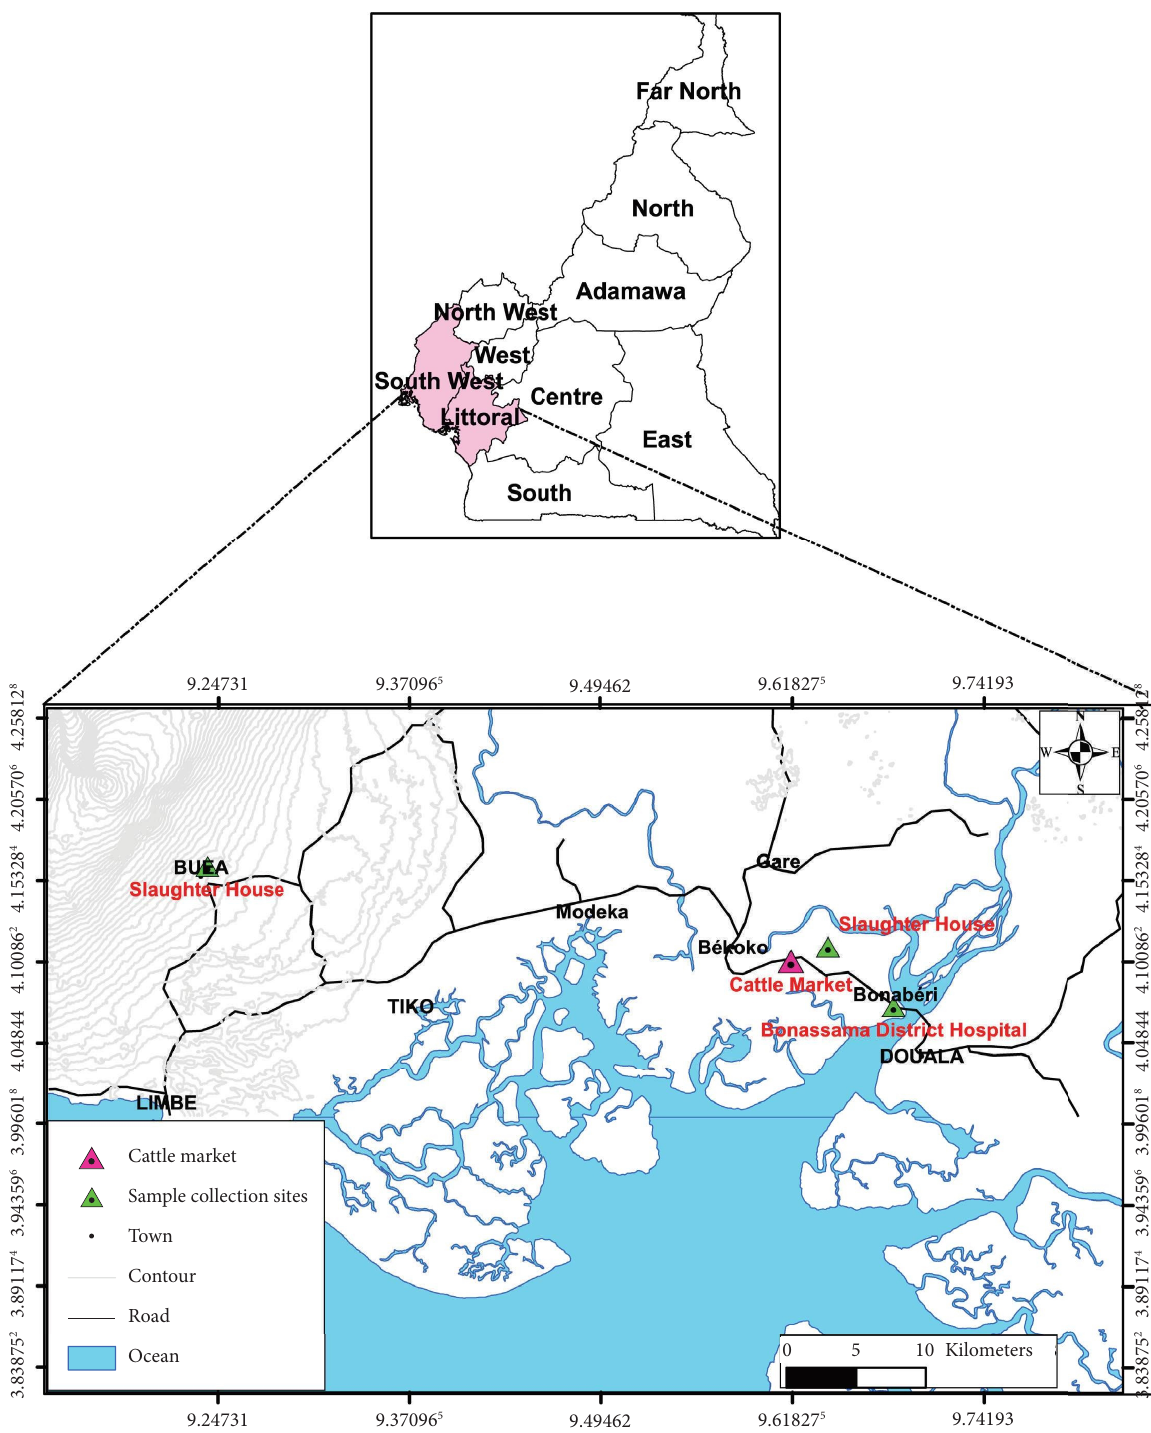
Figure 1: Map of Cameroon showing the sample collection sites in the southwest and littoral